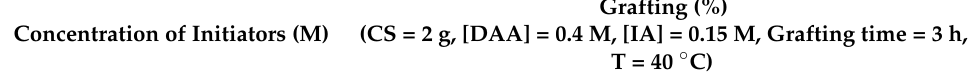
Concentration of Initiators